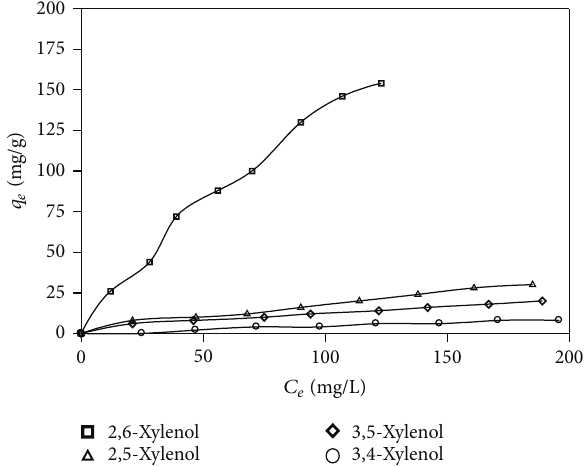
Figure 2: The adsorption isotherms of xylenol isomers on asphal- tene from aqueous solution at 25 ∘